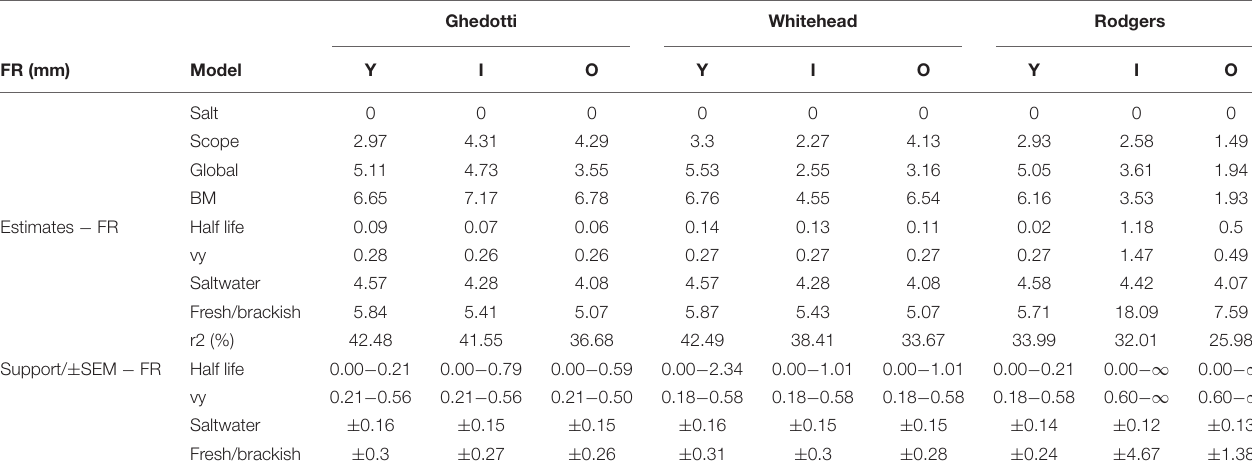
FIGURE 4 | Average body shape across all three developmental stages for each of the 19 species, shown as a deformation of overall body shape for all specimens. Shape variation has been magnified 3 × to enhance visualization. TABLE 1 | Models for FR (fineness ratio in mm) for Ghedotti and Davis (2013), Whitehead (2010), and Rodgers et al. (2018) trees. Ghedotti Whitehead